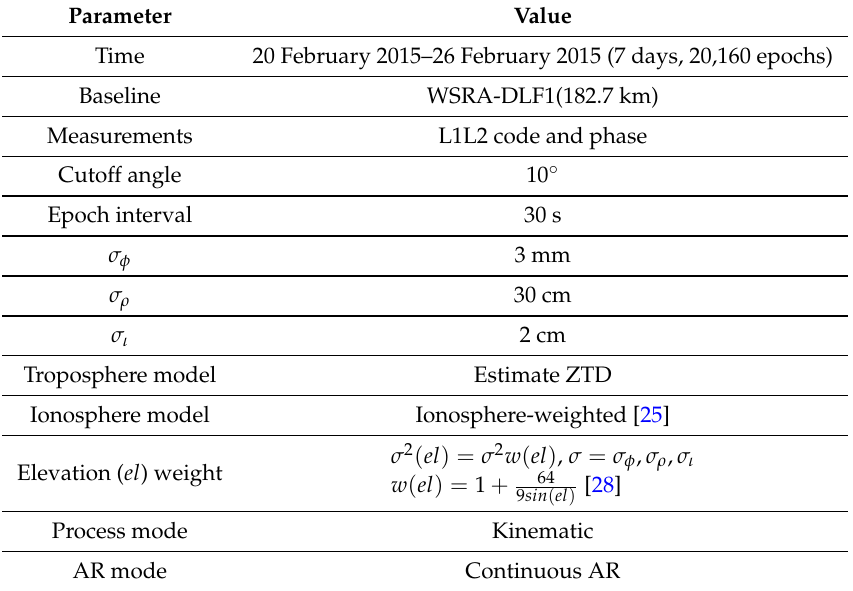
Table 4. The setup of the real data experiment. AR, Ambiguity